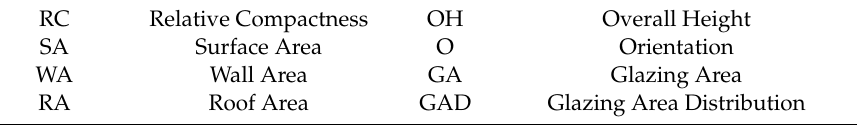
Table 1. Building parameters used as input variables for the